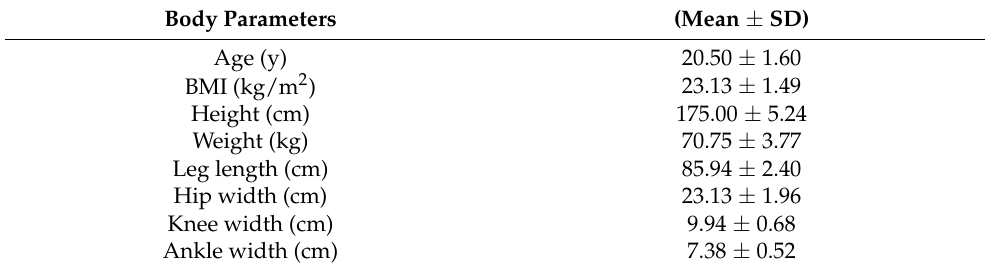
Table 1. Subject Body Parameters (mean ± SD).